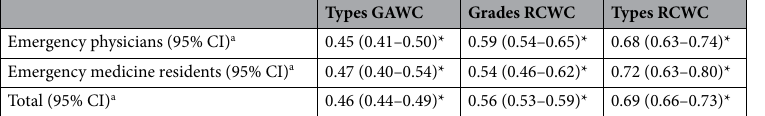
Table 2. Overall kappa (κ) values of the GAWC and RCWC. a Lower and upper bound of 95% confidence interval. *P-value < 0.05 indicating statistical significance.